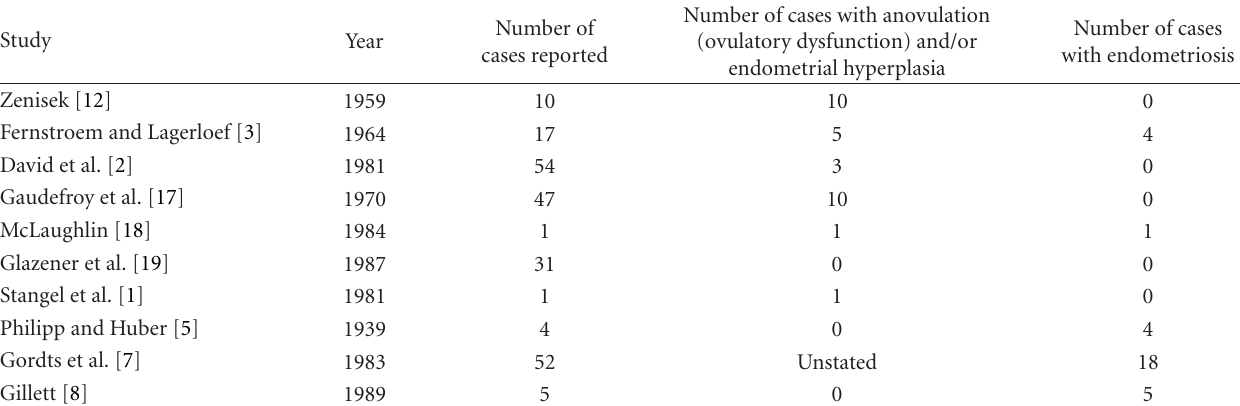
Table 2: Summary of published reports of the association of cornual polyps with anovulation (ovulatory dysfunction) and endometriosis.